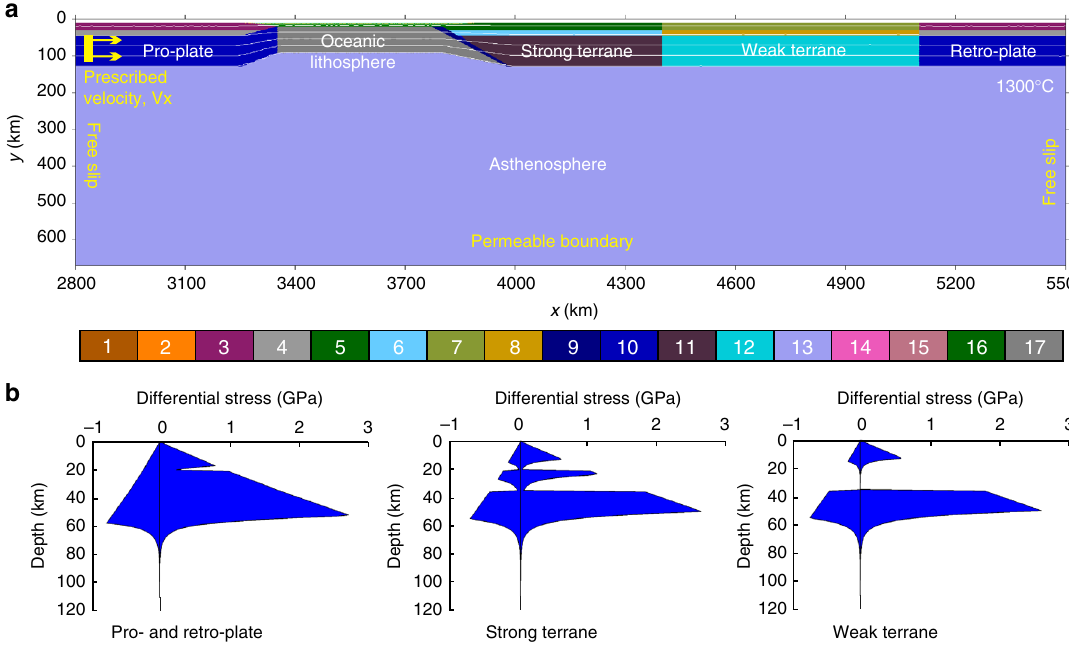
Fig. 2 Model setup. a Initial model con fi guration. Enlargement (2700 × 670 km) of the numerical box (6400 × 670 km) is shown. White lines are isotherms with an interval of 300 °C. A constant velocity of 5 cmyr − 1 is assigned within the pro-plate. Different colors refer to different lithologies, with the colorbar: 1/2 = sediment; 3 = pro-/retro-plate upper crust; 4 = pro-/retro-plate lower crust; 5 = strong terrane upper crust; 6 = strong terrane lower crust; 7 = weak terrane upper crust; 8 = weak terrane lower crust; 9 = initial weak zone; 10 = pro-lithospheric and retro-lithospheric mantle; 11 = strong terrane lithospheric mantle; 12 = weak terrane lithospheric mantle; 13 = asthenosphere; 14 = partially molten upper crust of the pro-plate and retro-plate; 15 = partially molten upper crust of the strong and weak terranes; 16 = oceanic crust; 17 = oceanic lithospheric mantle. b Three rheological structures of the continental lithosphere. Rheological strength pro fi les are obtained for the 120-km-thick lithosphere with an initial Moho temperature of 400 °C for pro- plate and retro-plate and of 450 °C for the strong and weak terranes. The prescribed constant strain rate is 10 − 16 s −